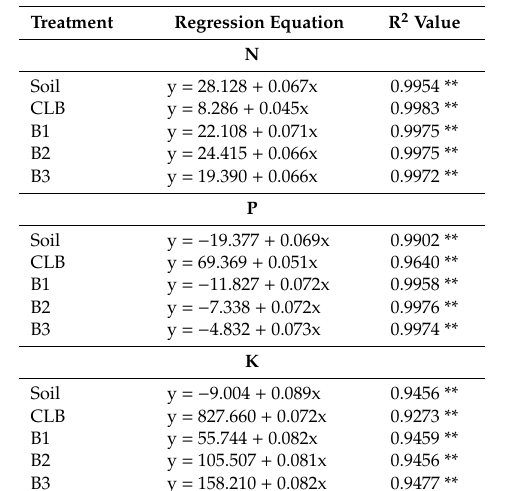
Table 7. Regression equations and R 2 values in relation to nitrogen, phosphorus, and potassium concentrations and nitrogen, phosphorus, and potassium contents remaining in the equilibrium solutions of